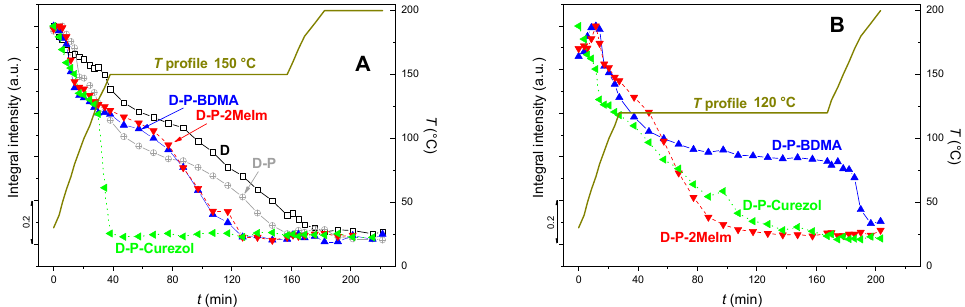
Figure 7. Time-dependent integral intensity changes in the characteristic epoxy band of 915 cm − 1 with thermal curing. The temperature profile that was followed with time is depicted, as well: ( A ) 150 ◦ C and ( B ) 120 ◦ C.